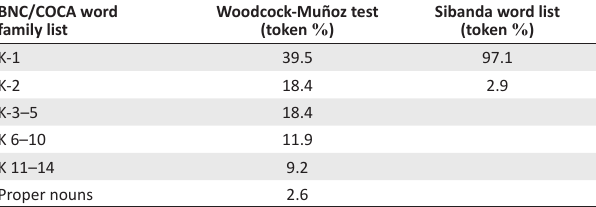
TABLE 10: Word family representations in the active and receptive vocabulary tests. BNC/COCA word family list TABLE 9: Pearson’s correlation coefficients of active and receptive word